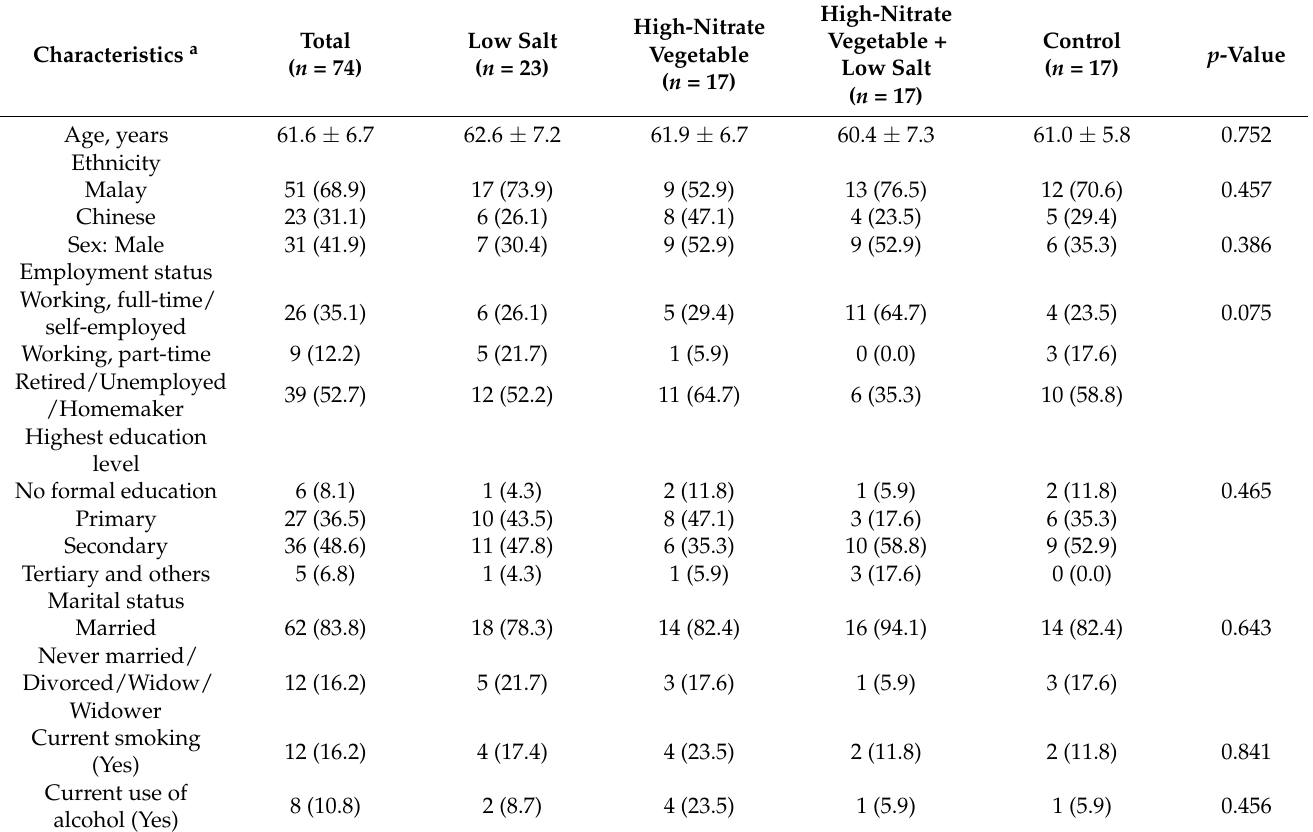
Table 1. The baseline characteristics of the